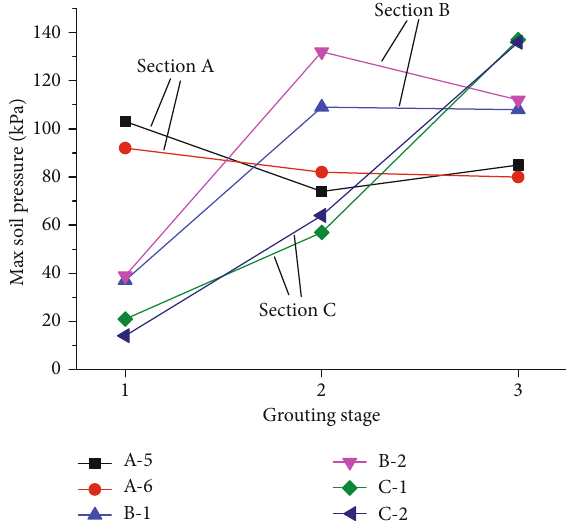
Figure 12: Max soil pressure in di ff erent grouting